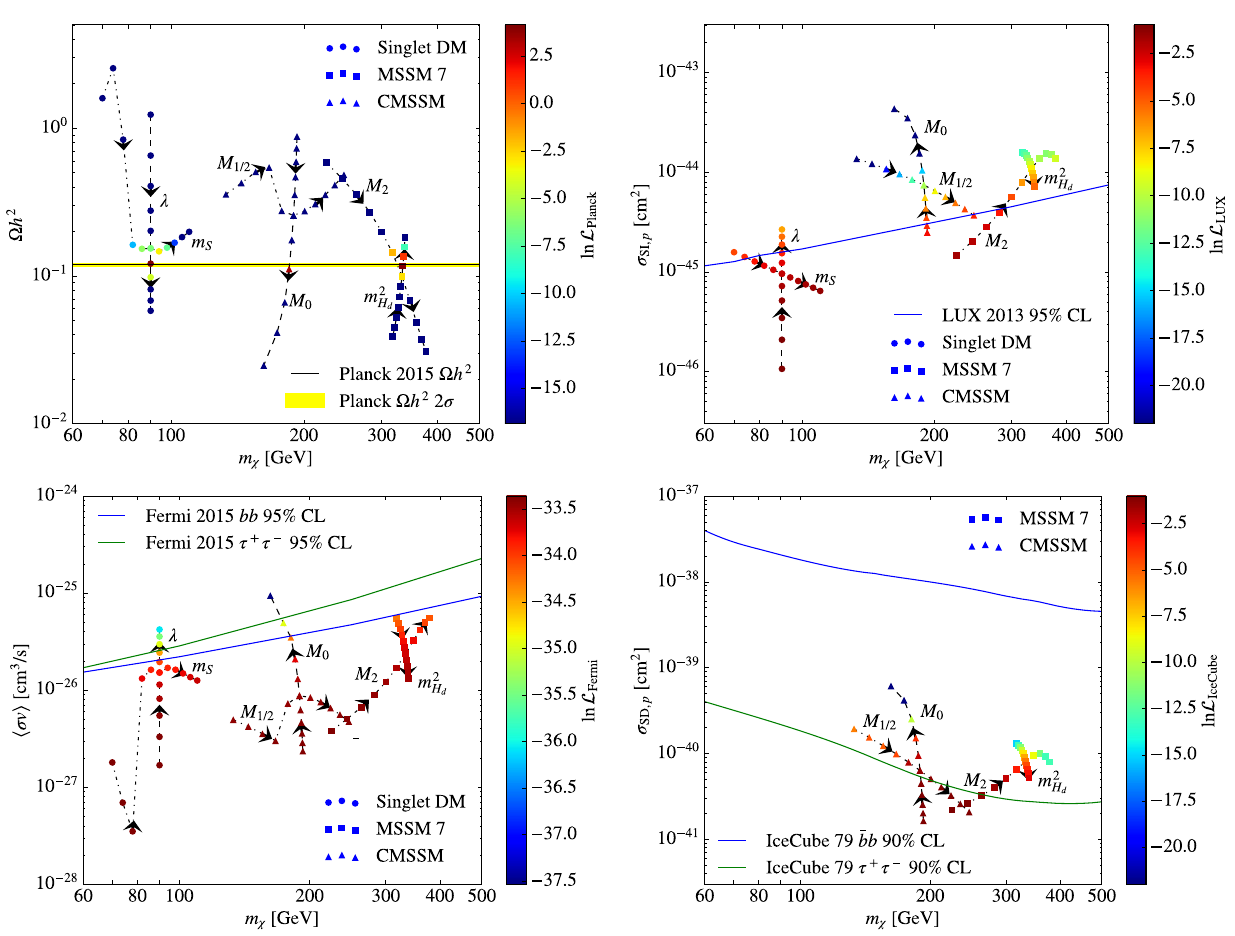
Fig. 6 Tracks in observable space corresponding to spokes in model parameter space. The arrows point in the direction of increasing param- eter values. Clockwise from the top-left, panels show the DM relic density, spin-independent and spin-dependent DM-proton scattering cross sections, and the velocity-averaged DM annihilation cross sec- tion. Points are colour-coded with a Gaussian likelihood based on the Planck 2015 analysis, the LUX 2013 likelihood from DDCalc , the Ice-